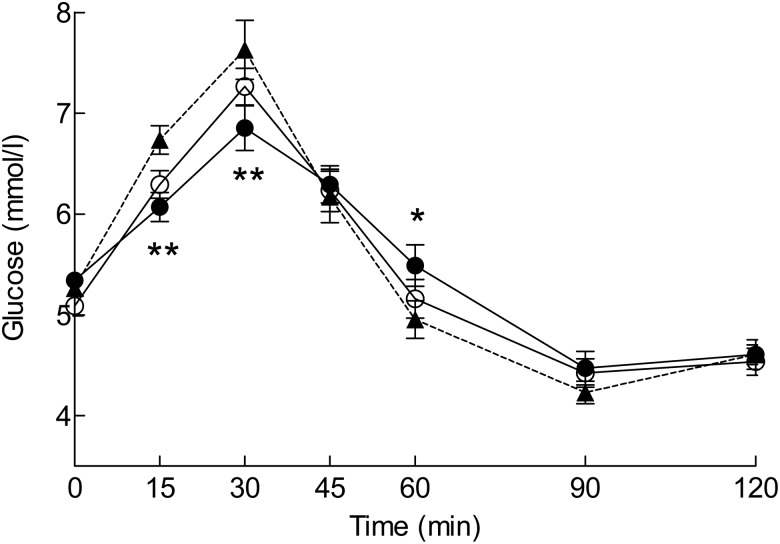
Plasma glucose concentrations after ingestion of the test products: reference (▲); blackcurrant nectar (●); lingonberry nectar (○). Values are means (n 17), with standard errors represented by vertical bars. P = 0·003 for product × time interaction in the mixed-model analysis. Mean value for the blackcurrant nectar was significantly different from that of the reference at an individual time point: * P < 0·05, ** P < 0·01 (post hoc analysis with Sidak adjustment).